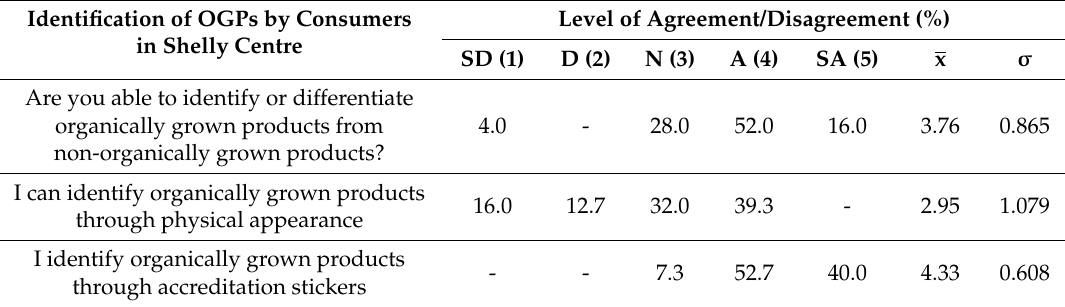
Table 6. Identification of OGPs by the interviewed consumers in Shelly Centre (n =